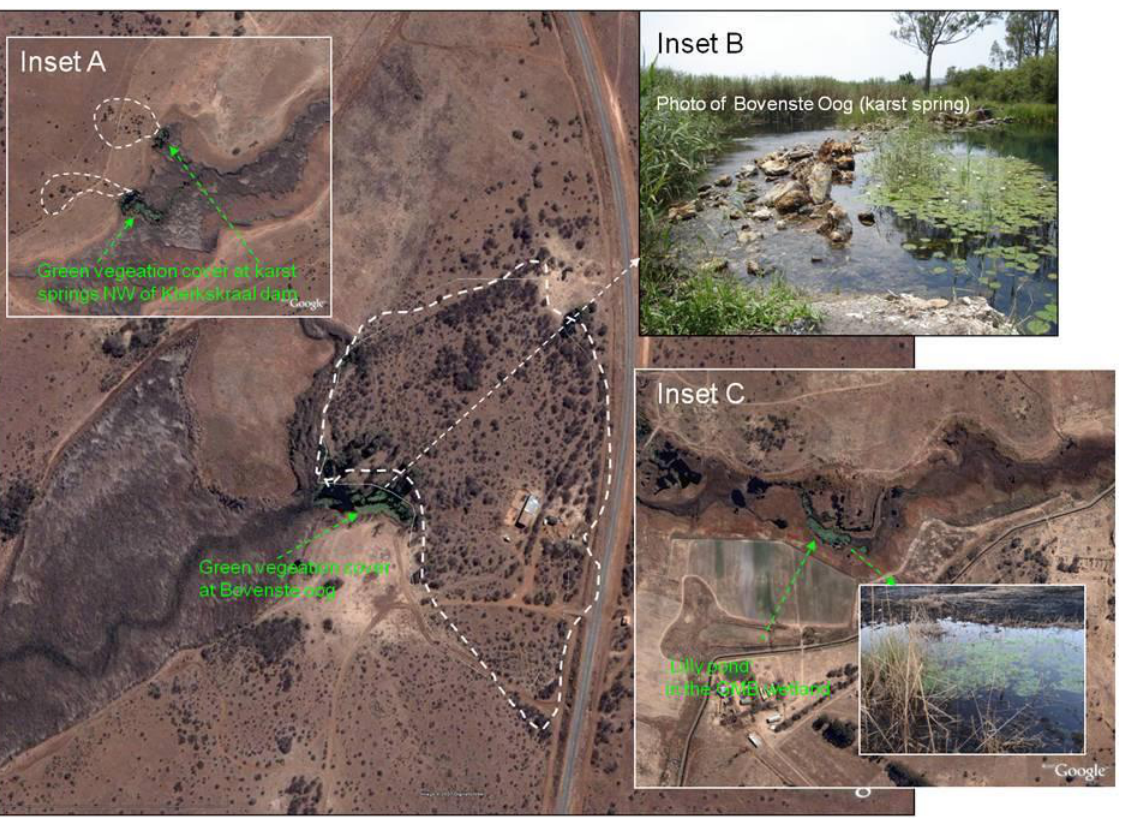
Figure 7. Green aquatic vegetation at springs and increasing bush density upstream of various eyes indicating discharge of unpolluted groundwater and shallower water tables, respectively. Main image: Bovenste Oog, upstream of Klerkskraal Dam, including a close up photograph of the eye (Inset B); Inset A: Two unnamed springs north-west of the Klerkskraal dam; Inset C: a satellite image of the upper part of the Gerhard Minnebron Wetland including a photo of the so-called ‗Lily pond‘ as a subaquatic spring discharging unpolluted dolomitic